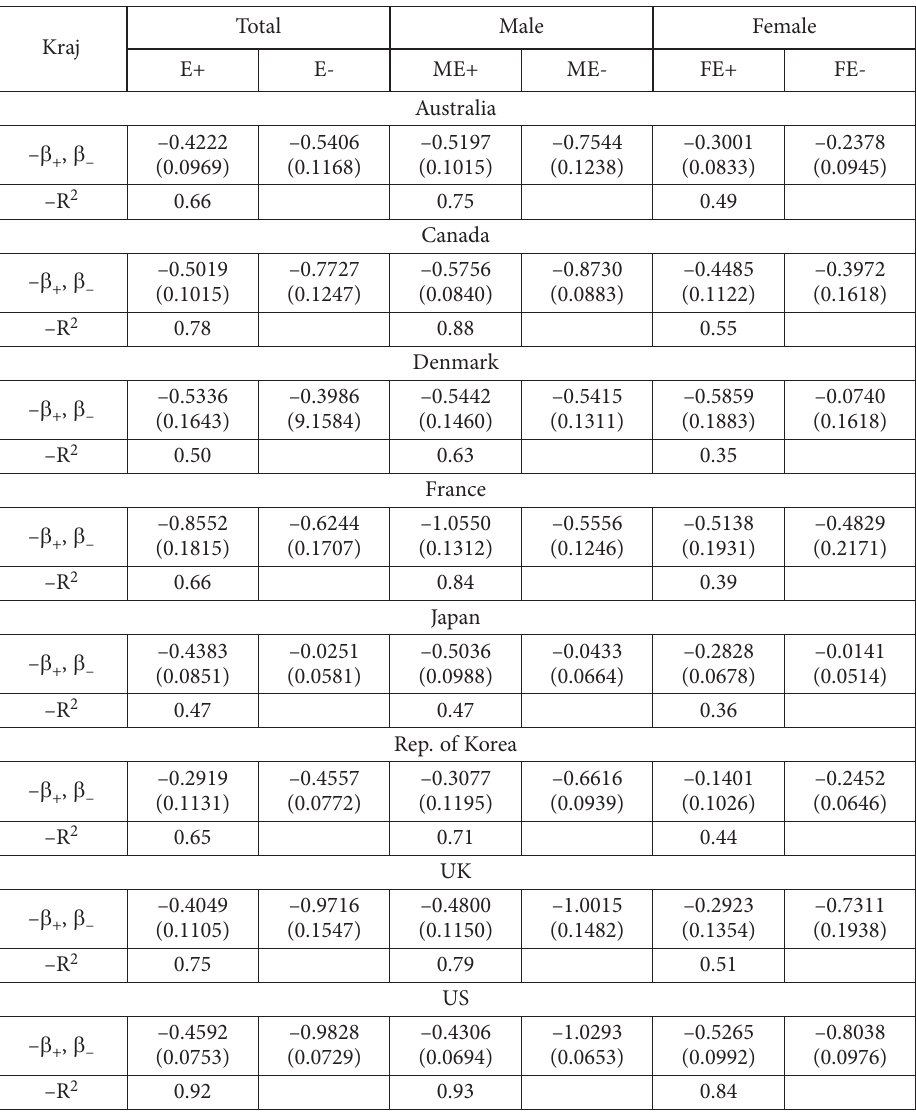
Table 3. Changes in a number of unemployed and changes in a number of working persons – results of the regression (model 4) in selected countries in the years 1981–2018 (source: own calculations